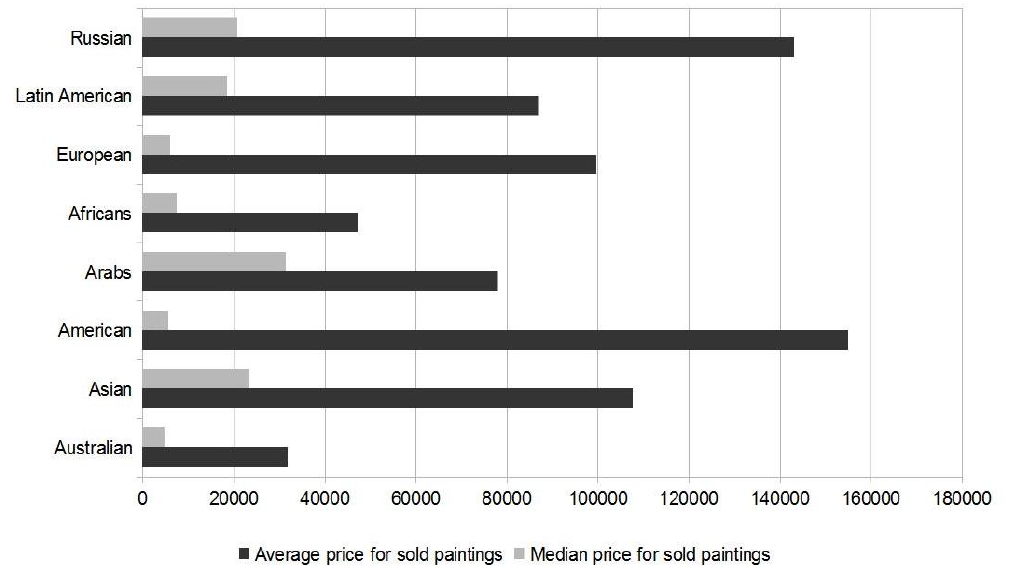
Figure 4. Distribution of prices by the artist’s